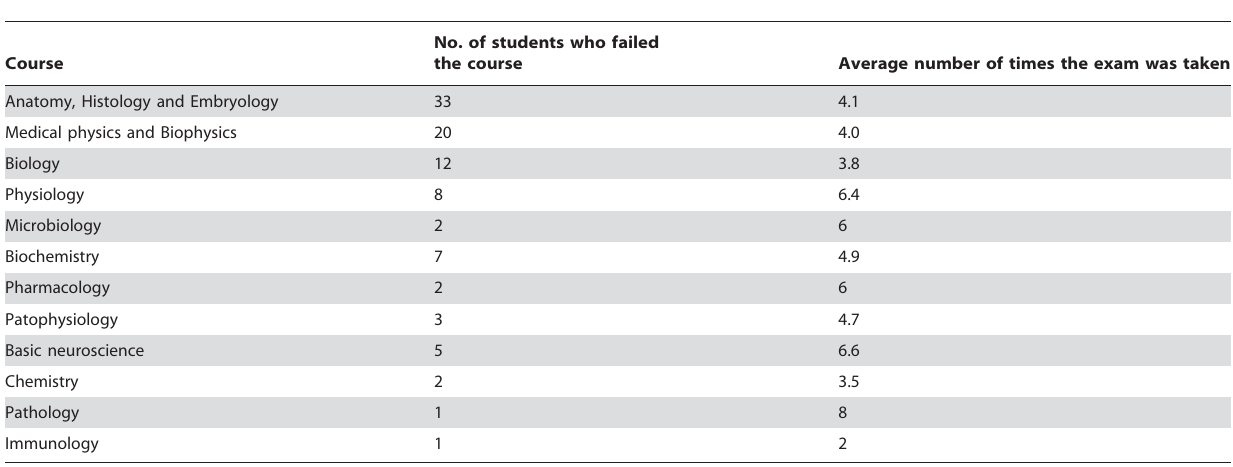
Table 2. Courses that attrition students took more than once.